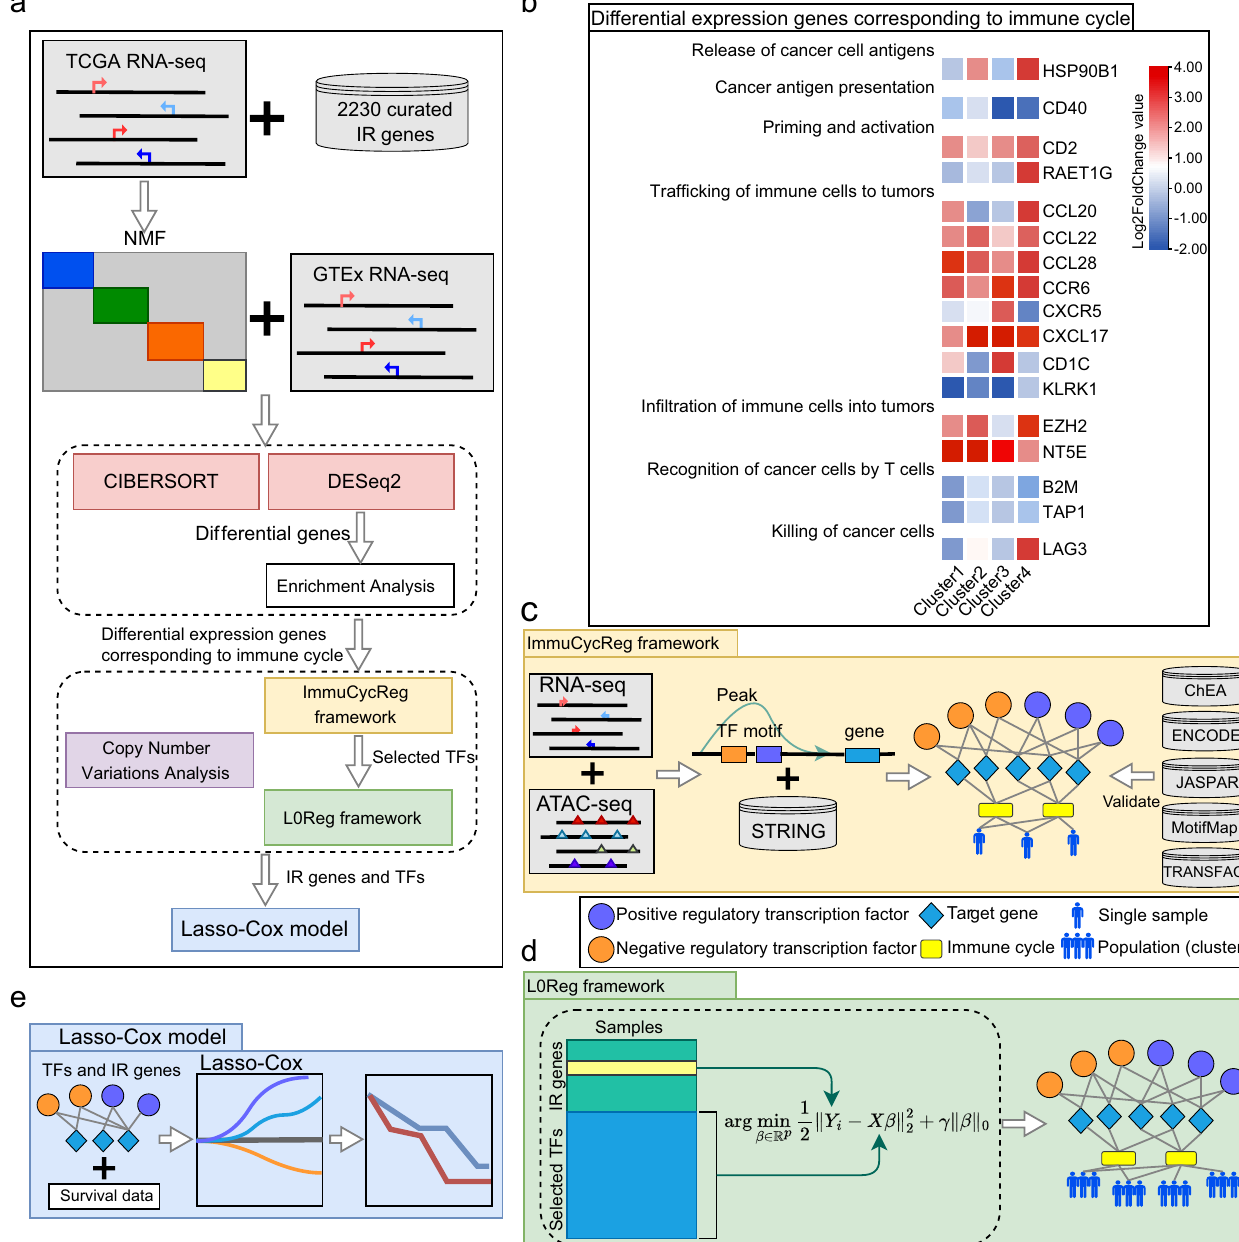
Fig. 1 A method for integration of single sample and population analysis. a Flowchart of our proposed framework. b The differential expression genes corresponding to immune cycle of TCGA-LUAD, red indicates high expression in such clusters, and blue indicates low expression. The expression amount was derived from the results of different analysis, in which P- value < 0.05 and Log2FoldChange > 1. c The diagram of ImmuCycReg framework. The RNA-seq (TCGA RNA-seq, GTEx RNA-seq) datasets, ATAC-seq dataset and STRING database 67 were used to construct regulatory network which was validated by the ChEA 56 , ENCODE 55 , JASPAR 54 , MotifMap 57 and TRANSFAC 58 databases. d The diagram of L0Reg framework. The input data consisted of two parts: an IR gene expression matrix Y and a TF encoding gene expression matrix X . And, the L0Reg framework output a gene regulatory network on population level. The orange circles are negative regulated TFs, the purple circles represent positive regulated TFs, the blue diamonds denote IR genes, the yellow rectangles denote immune cycle, and the humanoid signs are single sample or population (cluster). e For prognosis prediction, a risk scoring model was established on risk factors identi fi ed by Genotype-Tissue Expression (GTEx)) and multi-omics data (genome, transcriptome and proteome), to build a regulatory framework at single sample level for immune cycle analysis of TCGA-LUAD, namely Immune Cycle Regulatory framework (ImmuCycReg frame- work) (Fig. 1a). Then, we used IR genes as features and clustered